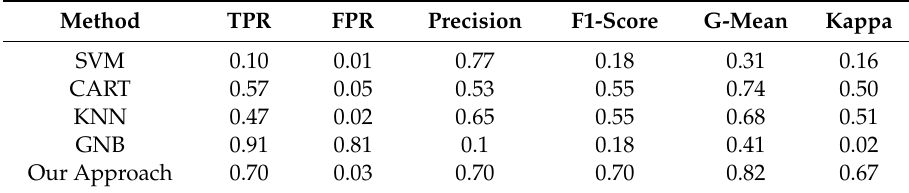
Table 4. Classification results of di ff erent machine learning